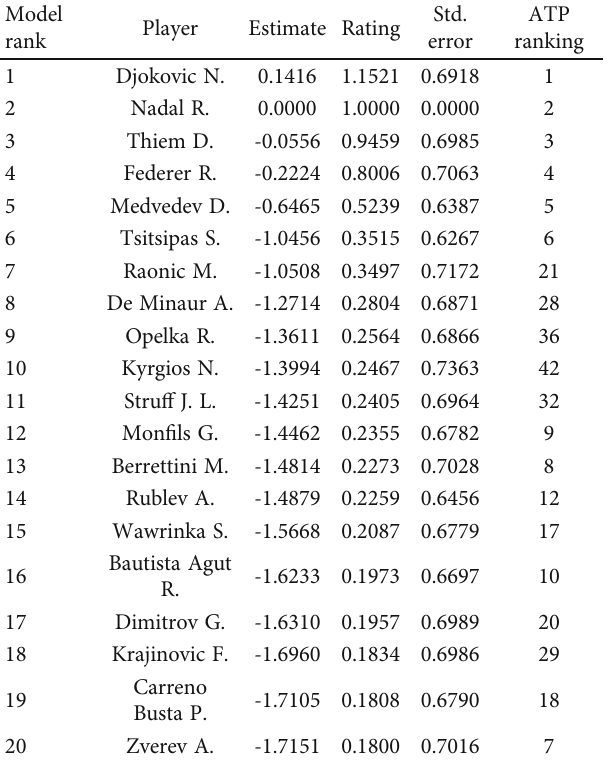
Figure 3: Match by match comparison of predicted probability with implied probability from bookmakers ’ average and best odds on all surfaces. Table 3: Model ranking and ATP ranking of top 20 players on hard